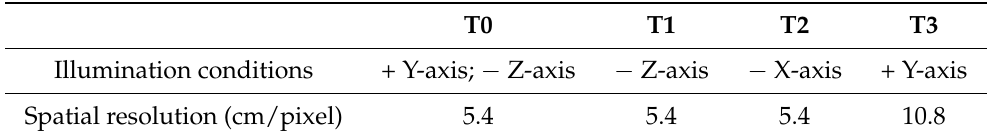
Table 5. Measured data